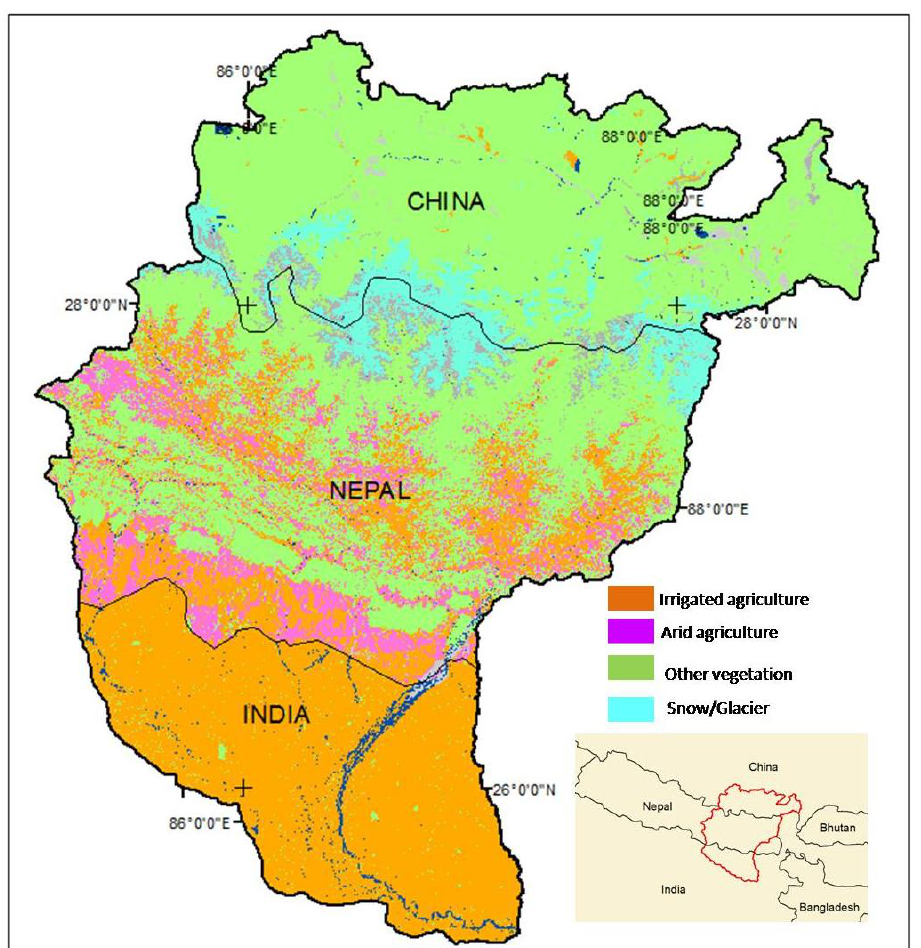
Figure S4. Location map of the additional study area (the Koshi River